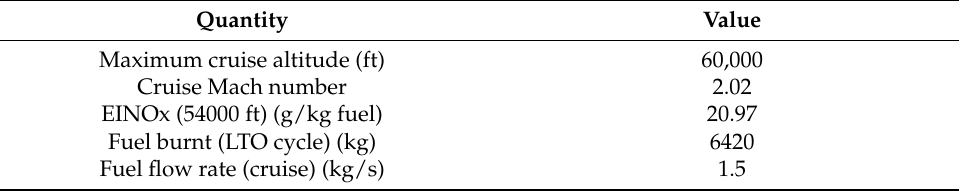
Table 3. Concorde